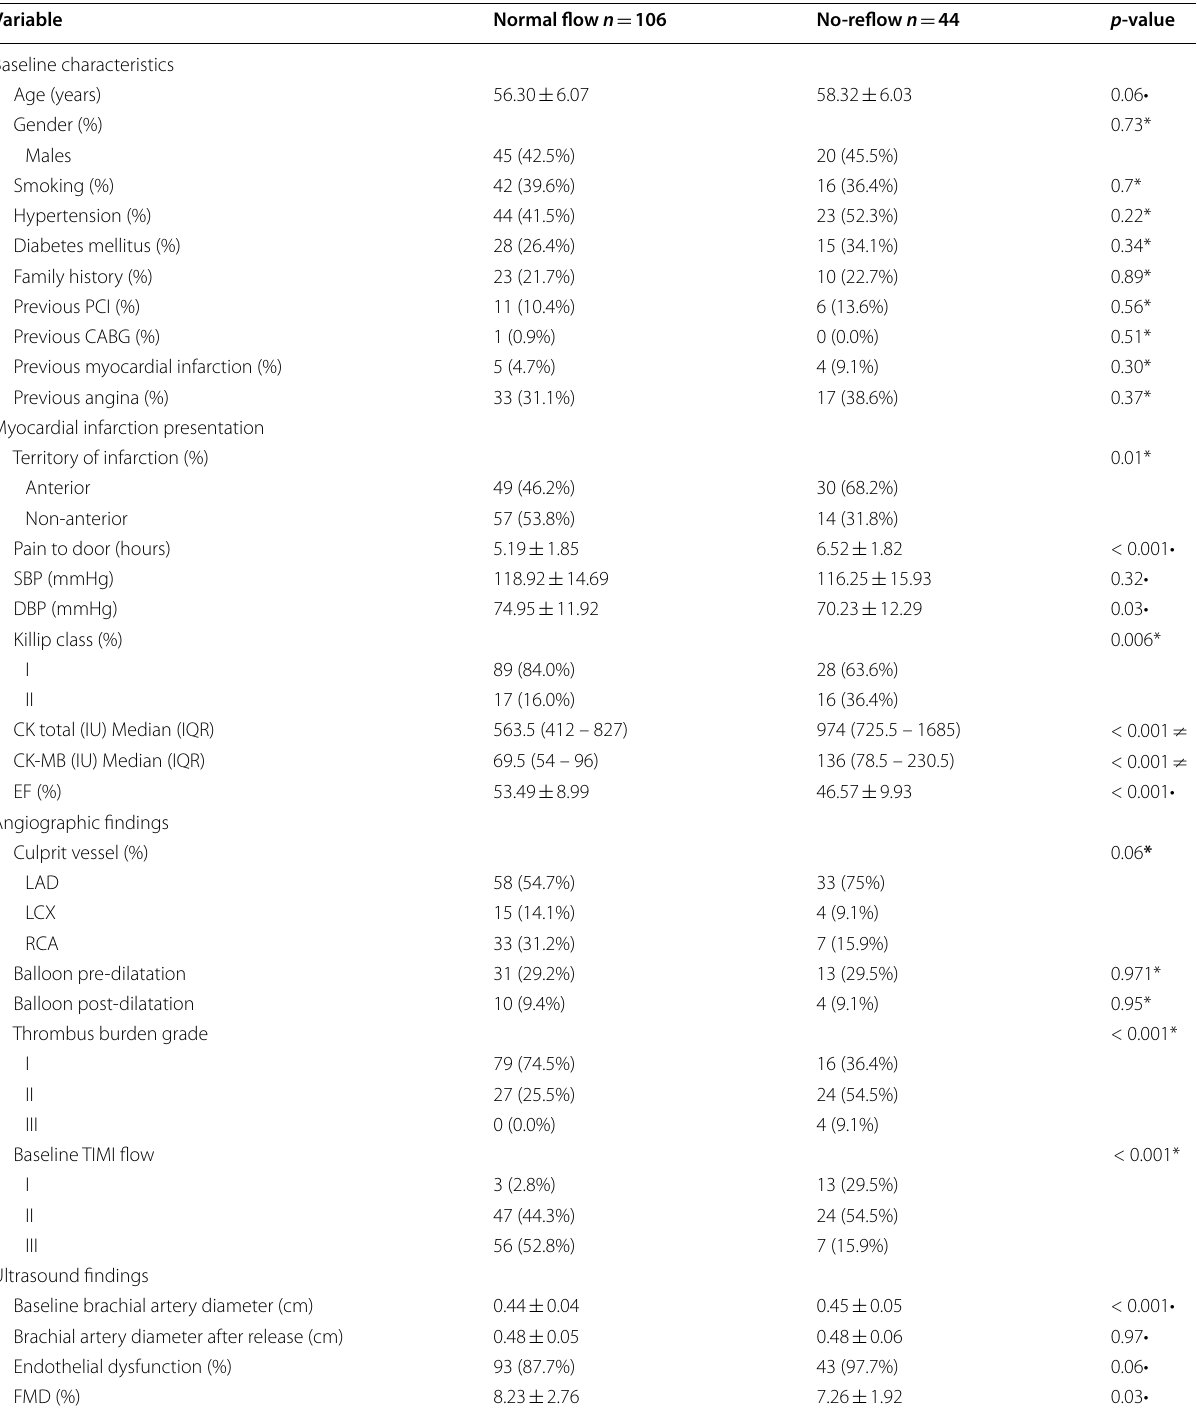
Table 1 Comparison between normal flow and no-reflow